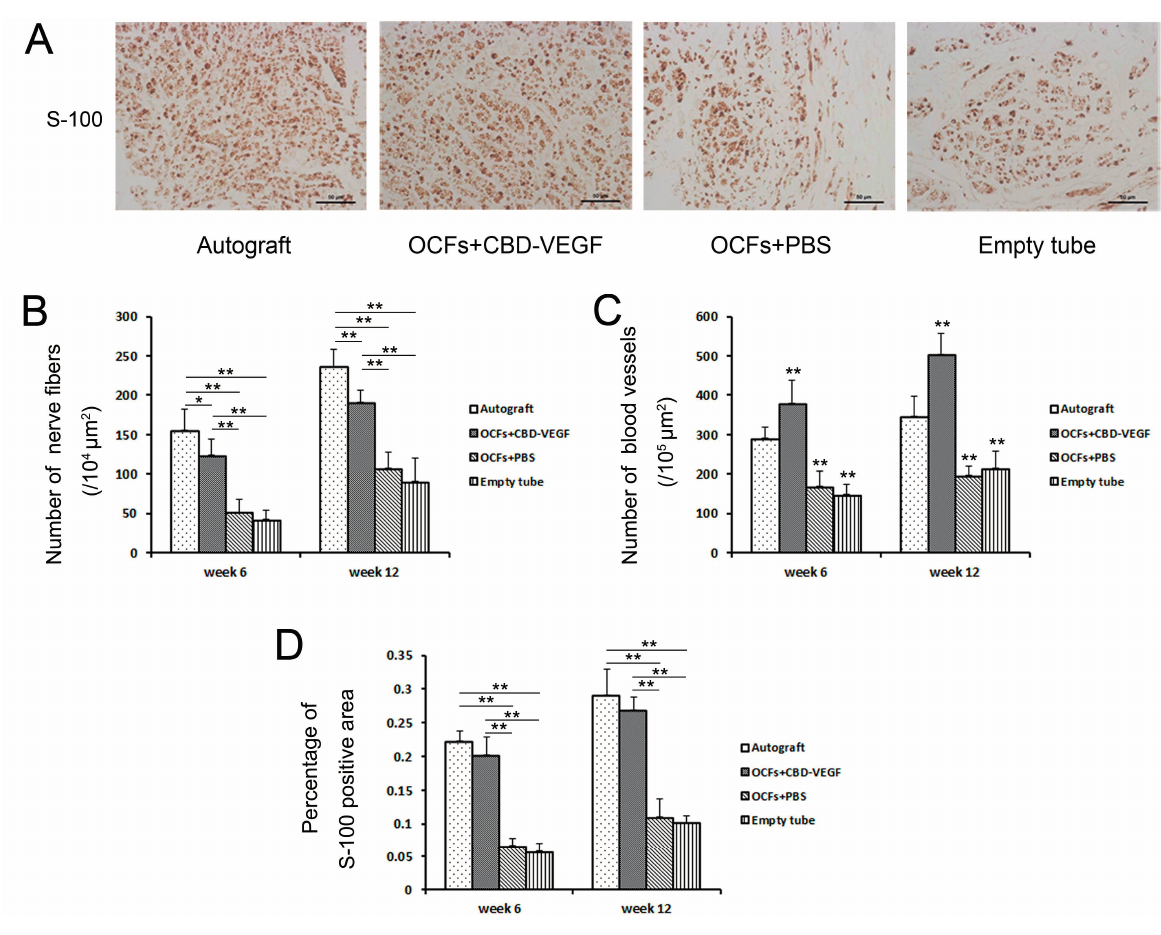
Figure 6. Immunohistochemical evaluation. ( A ) Immunostaining with anti-S-100 antibody. Light micrographs of the regenerating nerve at week 12 after transplantation. Scale bar, 50 µm; ( B ) Histogram comparing the number of NF-positive nerve fibers among the four groups; ( C ) Histograms showing the number of RECA-1-positive blood vessels taken from the various groups; ( D ) Statistical analysis of the percentage of S-100-positive area in each group. Data are expressed as mean ± SD, n = 5, * p < 0.05, ** p < 0.01 vs. autograft